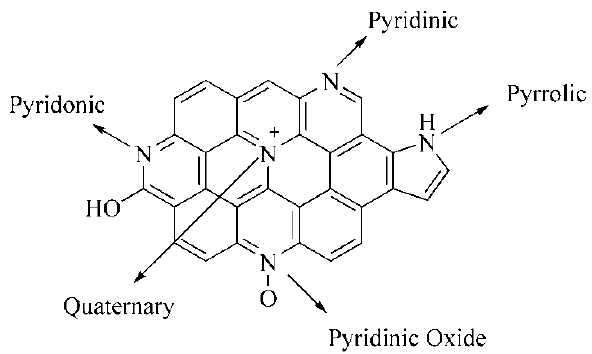
Table 4. Summary of reaction conditions and yields for epoxides conversion to cyclic carbonates using porous carbons materials (propylene oxide (PO), styrene oxide (SO), and epichlorohydrin